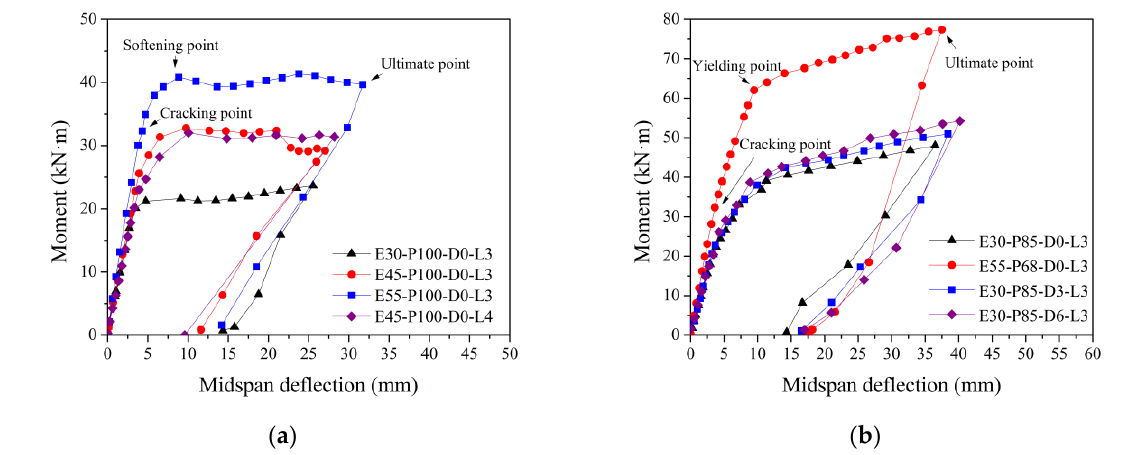
Figure 7. Moment – deflection relationships of specimens: ( a ) the fully prestressed specimens; ( b ) the partially prestressed specimens.